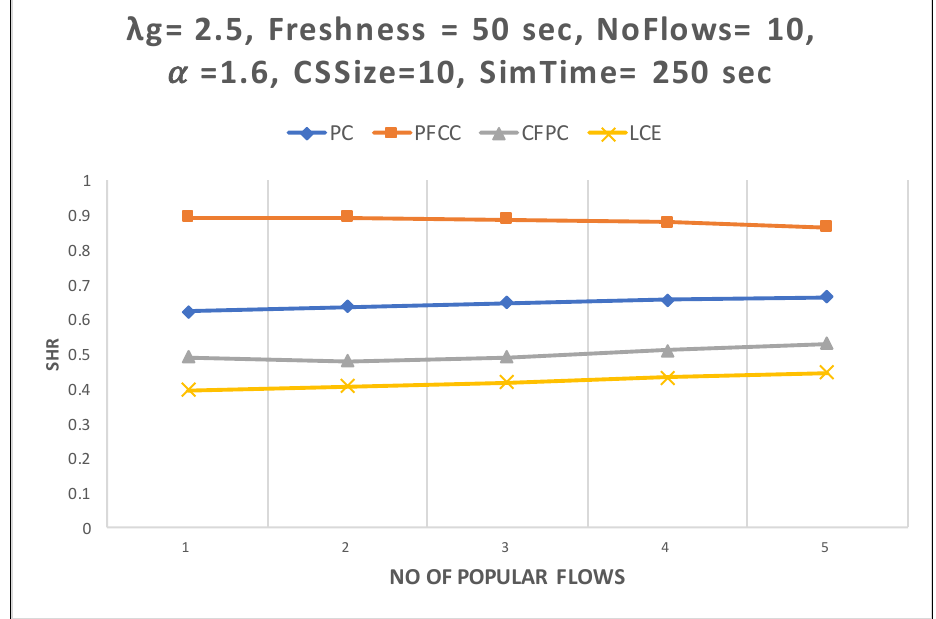
Figure 10. Server hit reduction ratio for popular traffic as a function of number of popular flows.